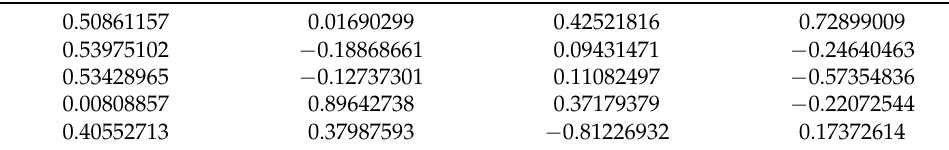
Table 2. Values obtained by downweighting.